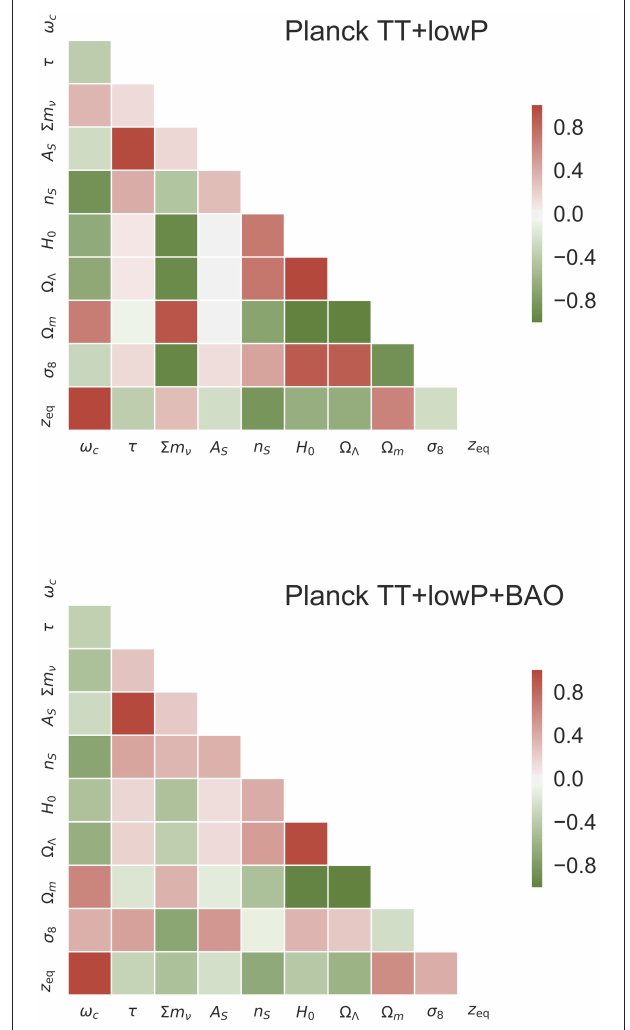
FIGURE 3 | Correlation matrices of a selection of cosmological parameters for the combinations of Planck TT+lowP (Upper) and Planck TT (Lower) . See section 5.1 for the description of these datasets. The darker the color shade, the stronger the degeneracy between the corresponding parameter pair. In both panels, the third row and the third column correspond to the correlation coefficients between 6 m ν and the remaining cosmological parameters. From the comparison between the two panels, it is clear that the inclusion of BAO data helps reduce the degeneracy between parameters (see e.g., the correlation between 6 m ν and H 0 , (cid:127) 3 ); in a few cases, in fact, the inclusion of BAO reverts the degeneracy (see e.g., the correlation between 6 m ν and n s